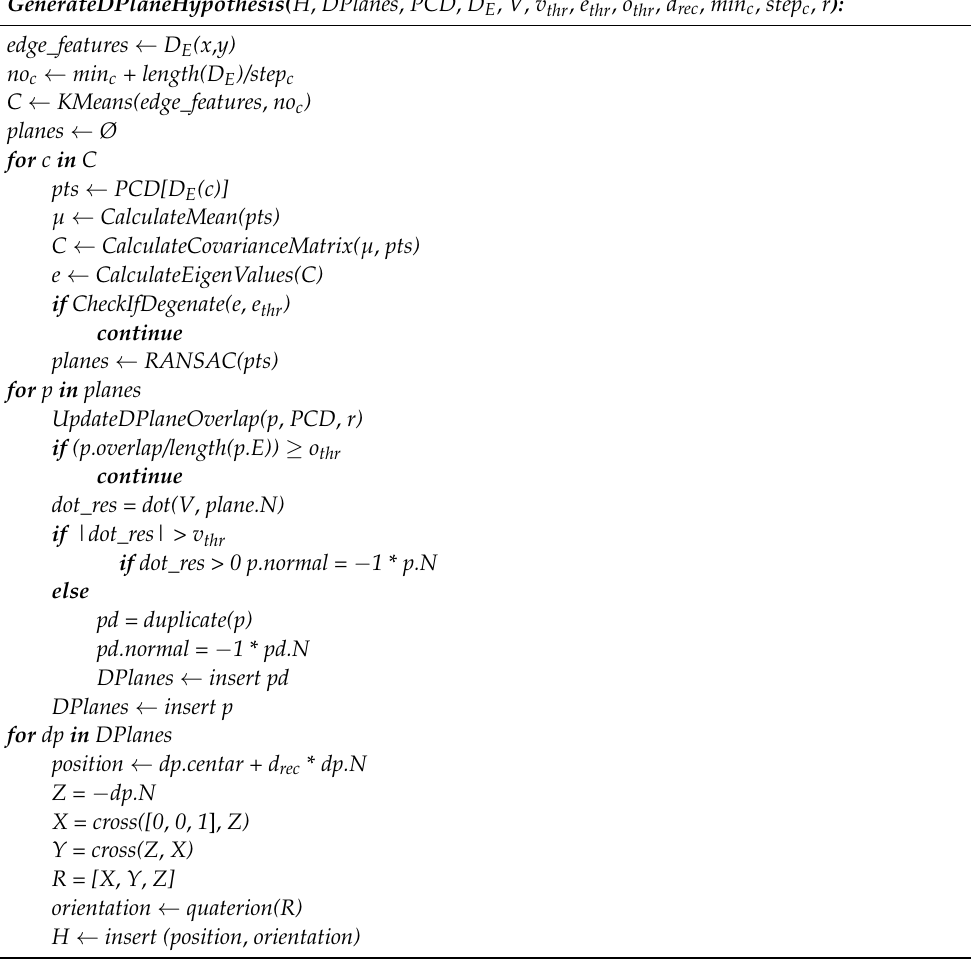
Algorithm 4. Algorithm for creation of DPlanes and their